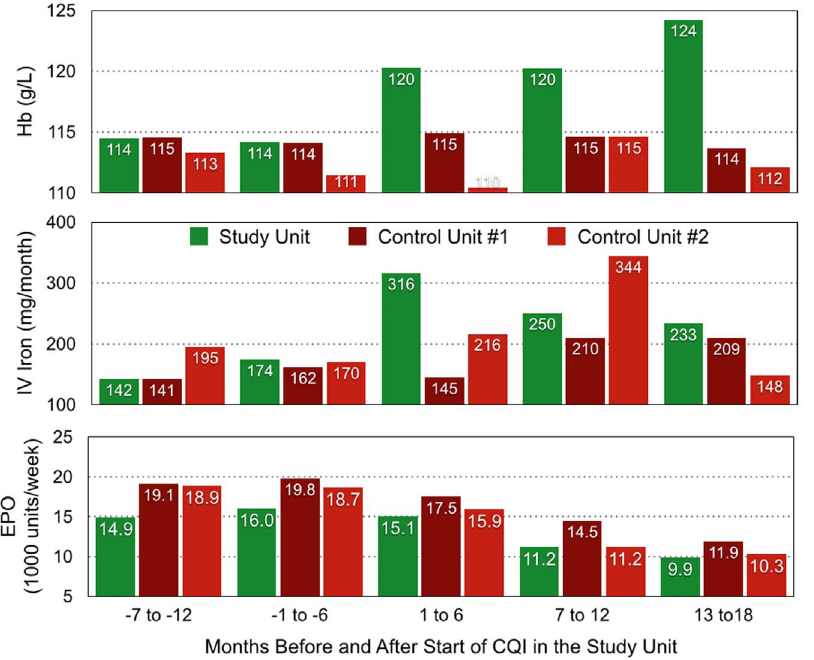
Figure 8. Patient median Hb and mean IV iron and EPO administered in the CQI study and two control units. Data are summarized for two 6-month periods before and three 6-month periods after start of the CQI process in the CQI study unit.